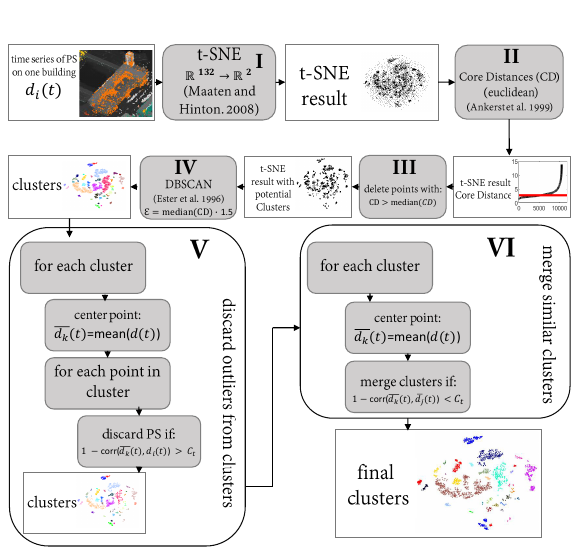
Figure 4. Schematic workflow of the clustering process. The M dimensional PS-points on a single building are embedded into a 2D space via t-SNE. For all points in this embedding the core distance CD is estimated. Points that have a CD greater than the overall median are then excluded. DBSCAN is then performed on the remaining points. For each point in each cluster the distance to the clusters center of gravity in the original M dimensional deformation space is then calculated.